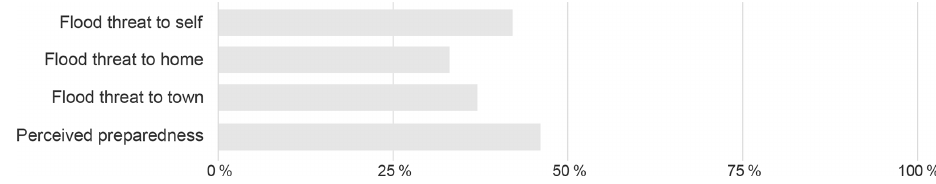
Figure 3. Percentage of panel respondents for whom the perceived change matches the actual change. Table 5. Summary of the main results. The column “Entire sample” shows the results from the linear regressions without interactions. The column “Significant interactions” shows the results from the linear regressions with interaction terms (gender or damage